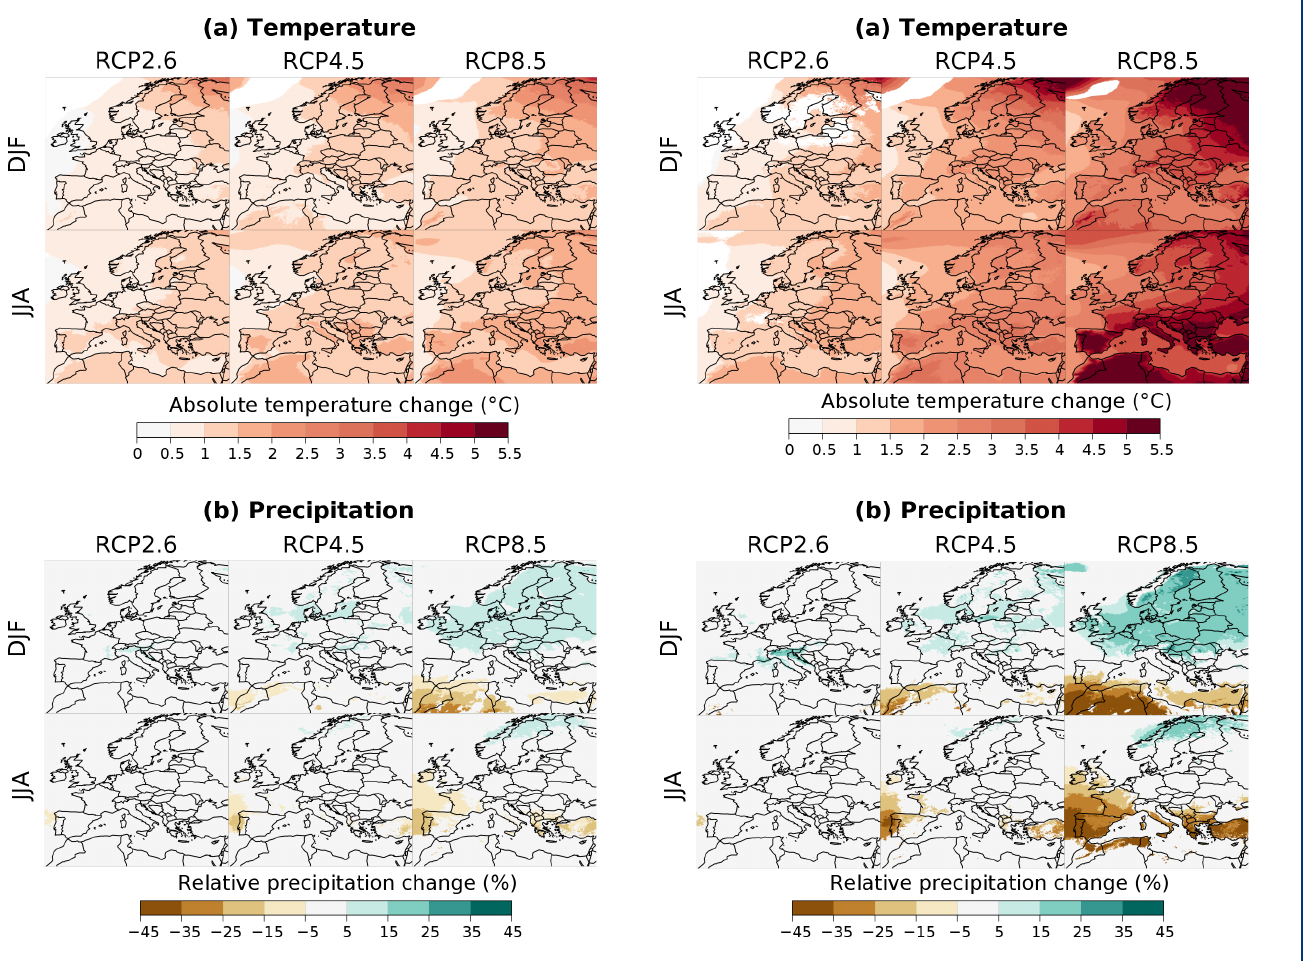
Figure 4. Balanced mean climate change response BM k ob- tained with the different RCP scenarios for the near future (2021– 2050) compared to the period 1981–2010 in winter (DJF) and summer (JJA). (a) Absolute changes in temperature. (b) Relative changes in precipitation. Only areas where the absolute response- to-uncertainty ratio is greater than 1 ( | BM k / BU | > 1) are shown.